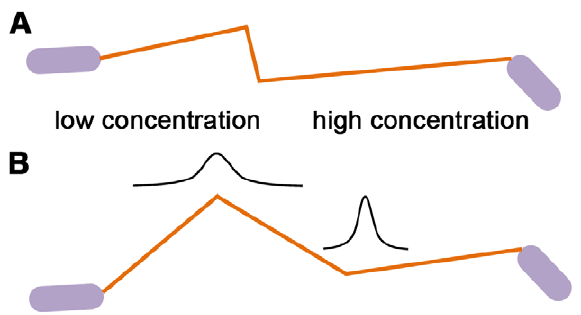
Figure 2. Illustration of the motion of an individual bacterium and an individual agent. A. A bacterium’s motion in chemical gradients is a biased random walk towards areas of higher chemical concentration. A bacterium makes longer excursions when it moves in areas of higher chemical gradients after which it performs a random switch of direction, known as a tumble. B. The motion of an individual agent is composed of equal sized excursions after which the agent tumbles. The tumble is a change in direction taken from a Gaussian distribution whose variance is a function of the chemical concentration. When the chemical gradient is small, the variance is large, and vice versa.